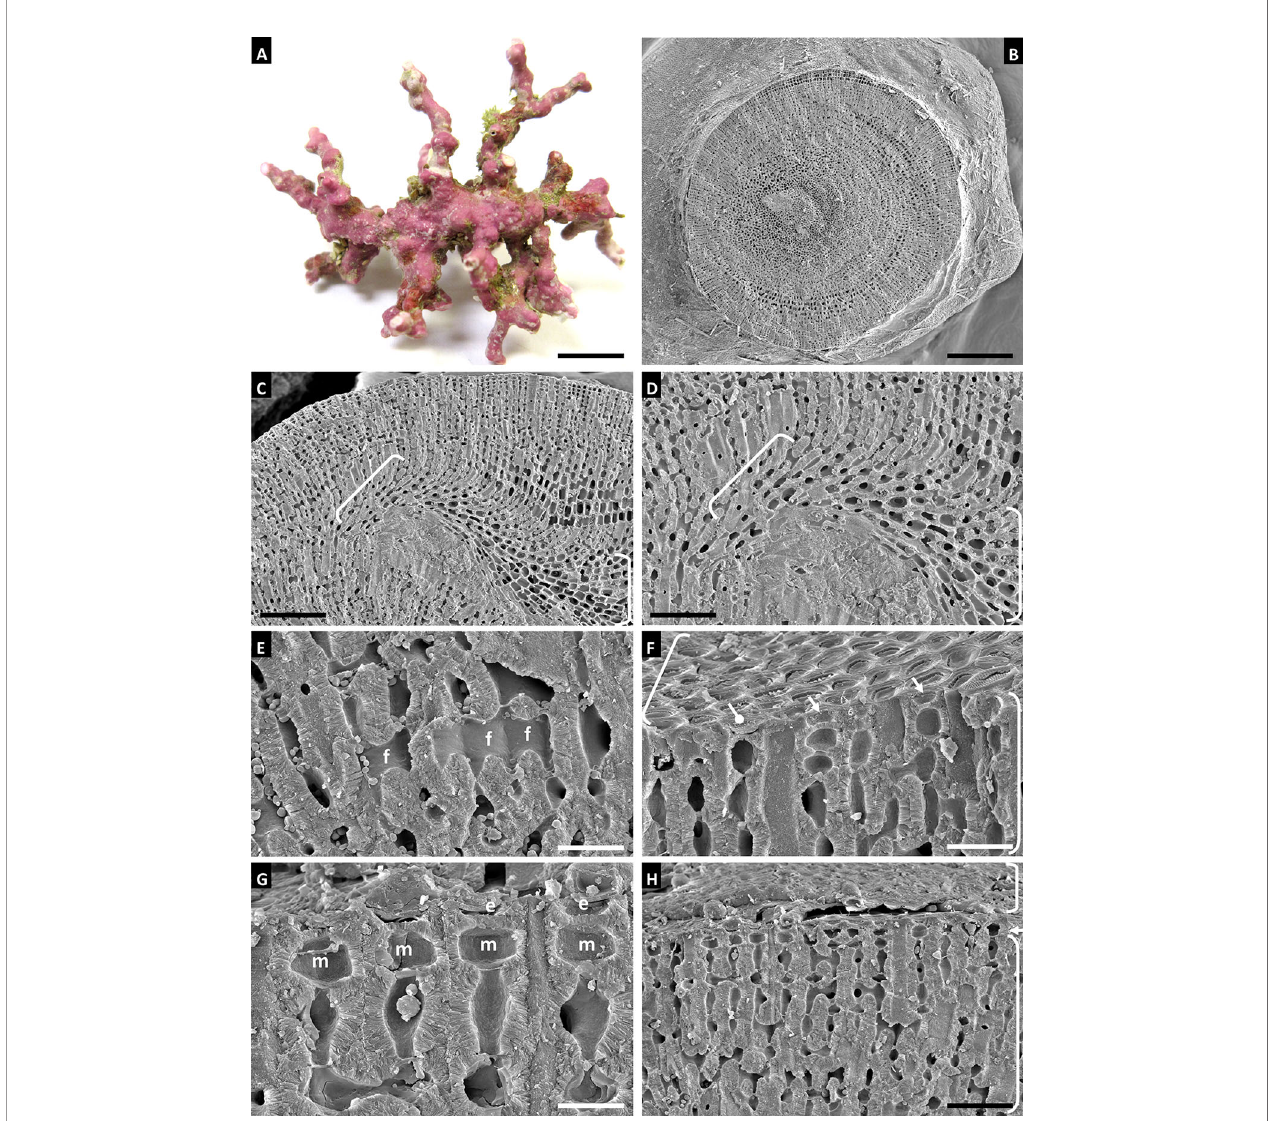
FIGURE 8 | Roseolithon purii , voucher no. LAF 7384 (A-H). (A) Thallus habit. Scale bar = 0.4 cm. (B) Protuberance cross section showing radial construction and partial surface view of thallus at base of protuberance. Scale bar = 260 µm. (C) Protuberance section showing location of new growth layer with secondary hypothallus (brackets) over older growth layer. Scale bar = 100 µm. (D) Magni fi ed view of secondary hypothallus (brackets). Scale bar = 53 µm. (E) Perithallus with cell fusions (f). Scale bar = 18 µm. (F) Surface view showing epithallus (upper bracket) and section view showing perithallus (lower bracket), and epithallial cells with roof intact (circle pointer) and roofs missing (arrows). Scale bar = 18 µm. (G) Intercalary meristematic cells (m) and epithallial cells in the process of sloughing (e). Scale bar = 10 µm. (H) Perithallus (lower bracket), intercalary meristem (arrow), and epithallus in the processing of sloughing off. Scale bar = 35